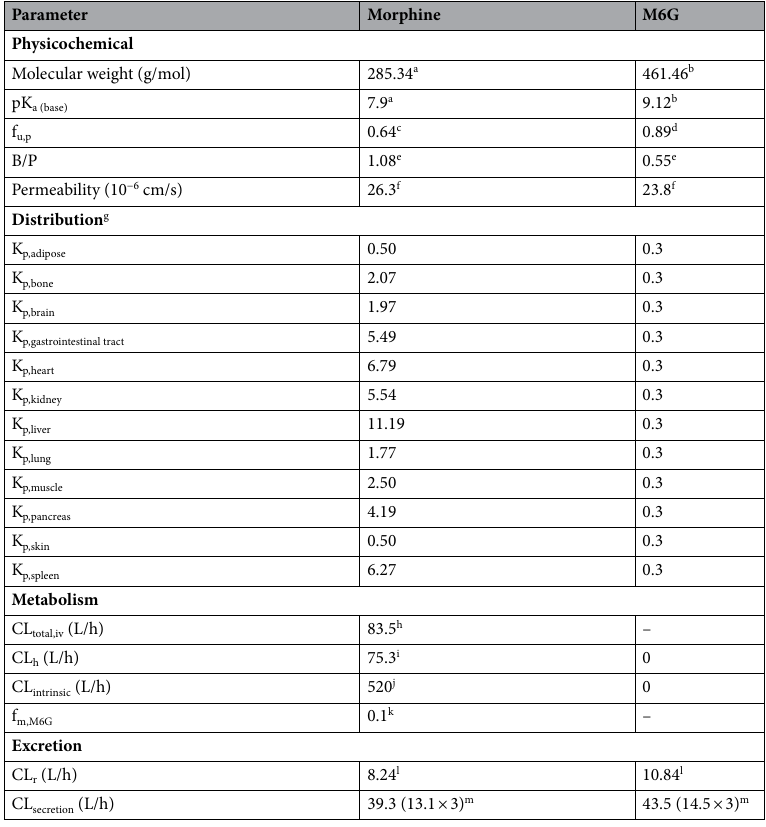
Table 2. The summary of morphine-M6G parent-metabolite full body PBPK model parameters. f u,p , fraction unbound in plasma; B/P, blood-to-plasma ratio; K p , tissue-to-plasma partition coefficient for specific organ/ tissue; CL total,iv , total body clearance after intravenous administration; CL h , hepatic clearance; CL intrinsic , metabolic intrinsic clearance; f m,M6G , fraction of morphine metabolism to M6G; CL r , renal clearance; CL secretion , unbound intrinsic kidney active secretion clearance at proximal tubule (clearance value of each proximal subsegment S1, S2, and S3). a 43,b collected from www. drugb ank. ca, c38,d39,e40,f experimentally determined using VPT-MPS as described in the “Methods” section, g predicted 44 and optimized as described in the “Methods” section, h31,i,j calculated as described in the “Methods” section, k47,l predicted using mechanistic kidney model 10 as described in the “Methods” section, m experimentally determined using VPT-MPS as described in the “Methods”